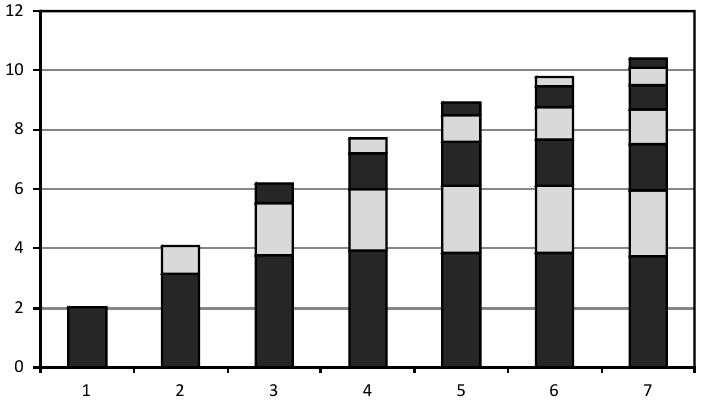
Fig. 2. The mean number and size distribution of agricultural parcels depending on the area of the field. The parcel size distribution within a field is shown with alternating black and